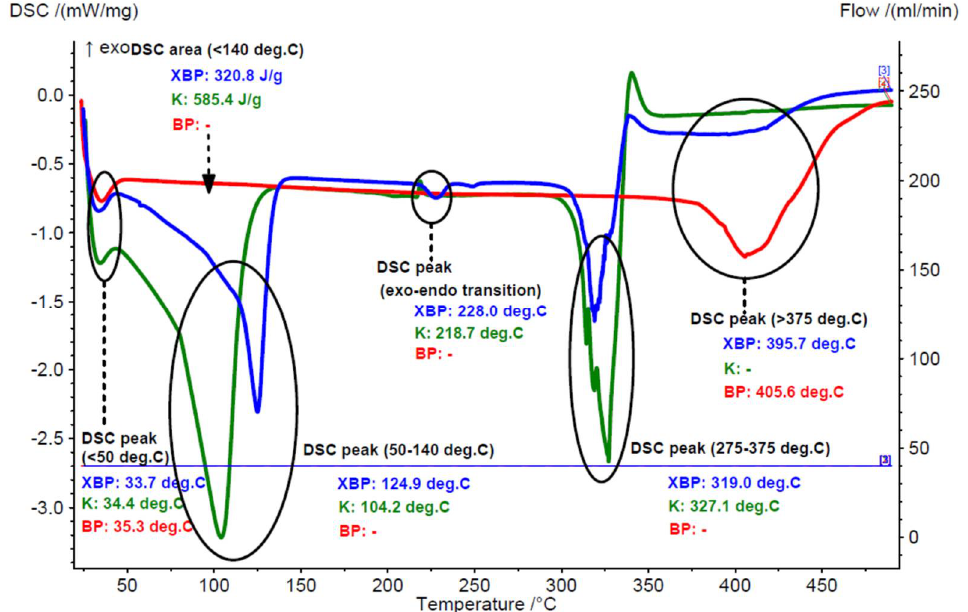
Figure 4. Superimposed DSC curves for the β -cyclodextrin/processed (boiling) breast chicken lipid complex (blue), β -cyclodextrin hydrate (green), and processed (boiling) breast chicken lipid fraction (red) (codes “XBP”, “K” and “BP”, duplicate samples